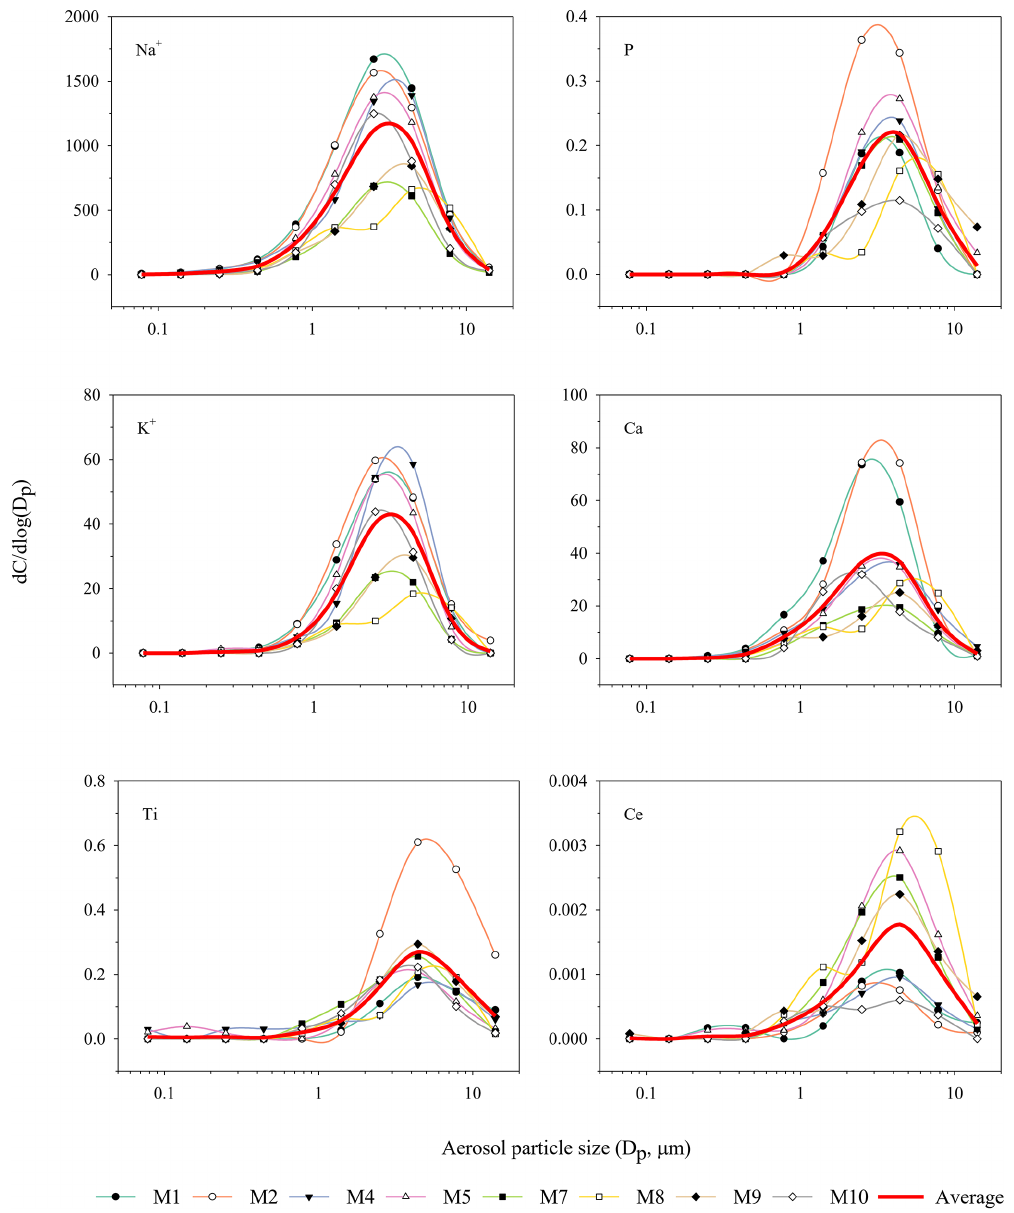
Figure 7. Particle-size distributions of the trace elements showing single-mode distribution in aerosols during November 2016–January 2017 austral summer over Palmer Station. d C/ dlog (D p ) is the normalized